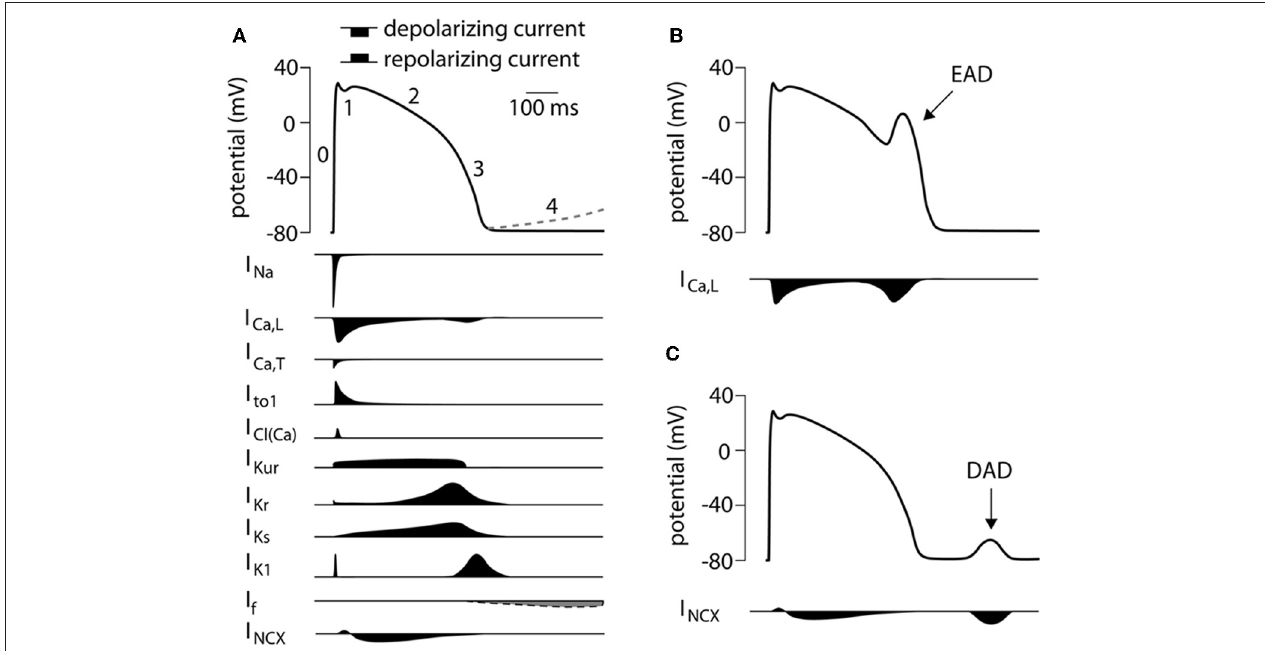
FIGURE 1 | (A) Schematic representation of a human ventricular action potential (top panel). Numbers denote the different phases of the ventricular action potential. The dashed line represents phase 4 depolarization normally present in cells from the conduction system and not in ventricular CMs. Underlying ionic membrane currents and their schematic time course are depicted below. (B) Schematic representation of an early afterdepolarization (EAD) and its underlying mechanism. (C) Schematic representation of